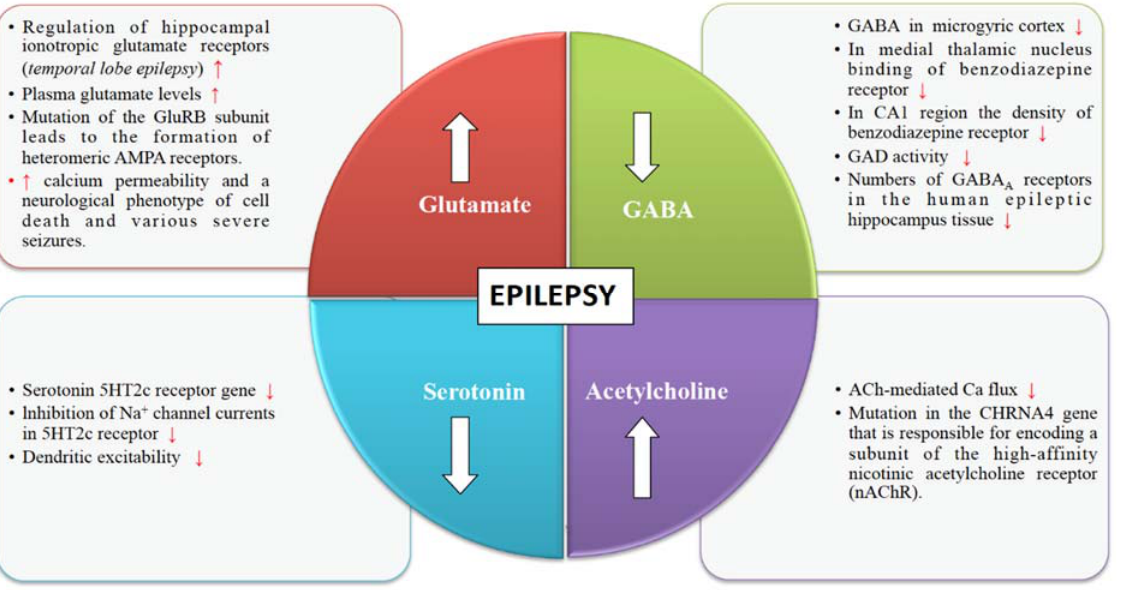
Figure 1. Neurotransmitter mediated changes in epilepsy. Different changes have been observed in the brain due to the increase in the levels of glutamate and acetylcholine and a decrease in the levels of serotonin and GABA. Such modulations due to various physiological conditions or comorbid situations have been reported, which should be taken into account while designing any pharmacological interventions in the epileptic patients.